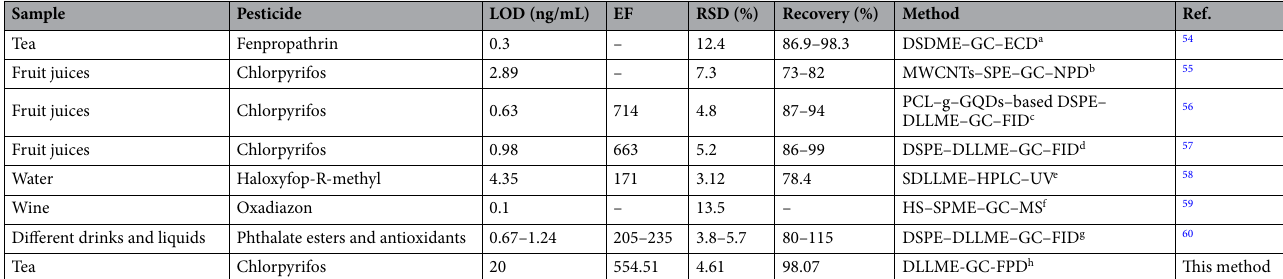
Table 2. Comparison of the presented method with the other methods used in preconcentration and determination of the studied pesticides. a Directly suspended droplet microextraction–gas